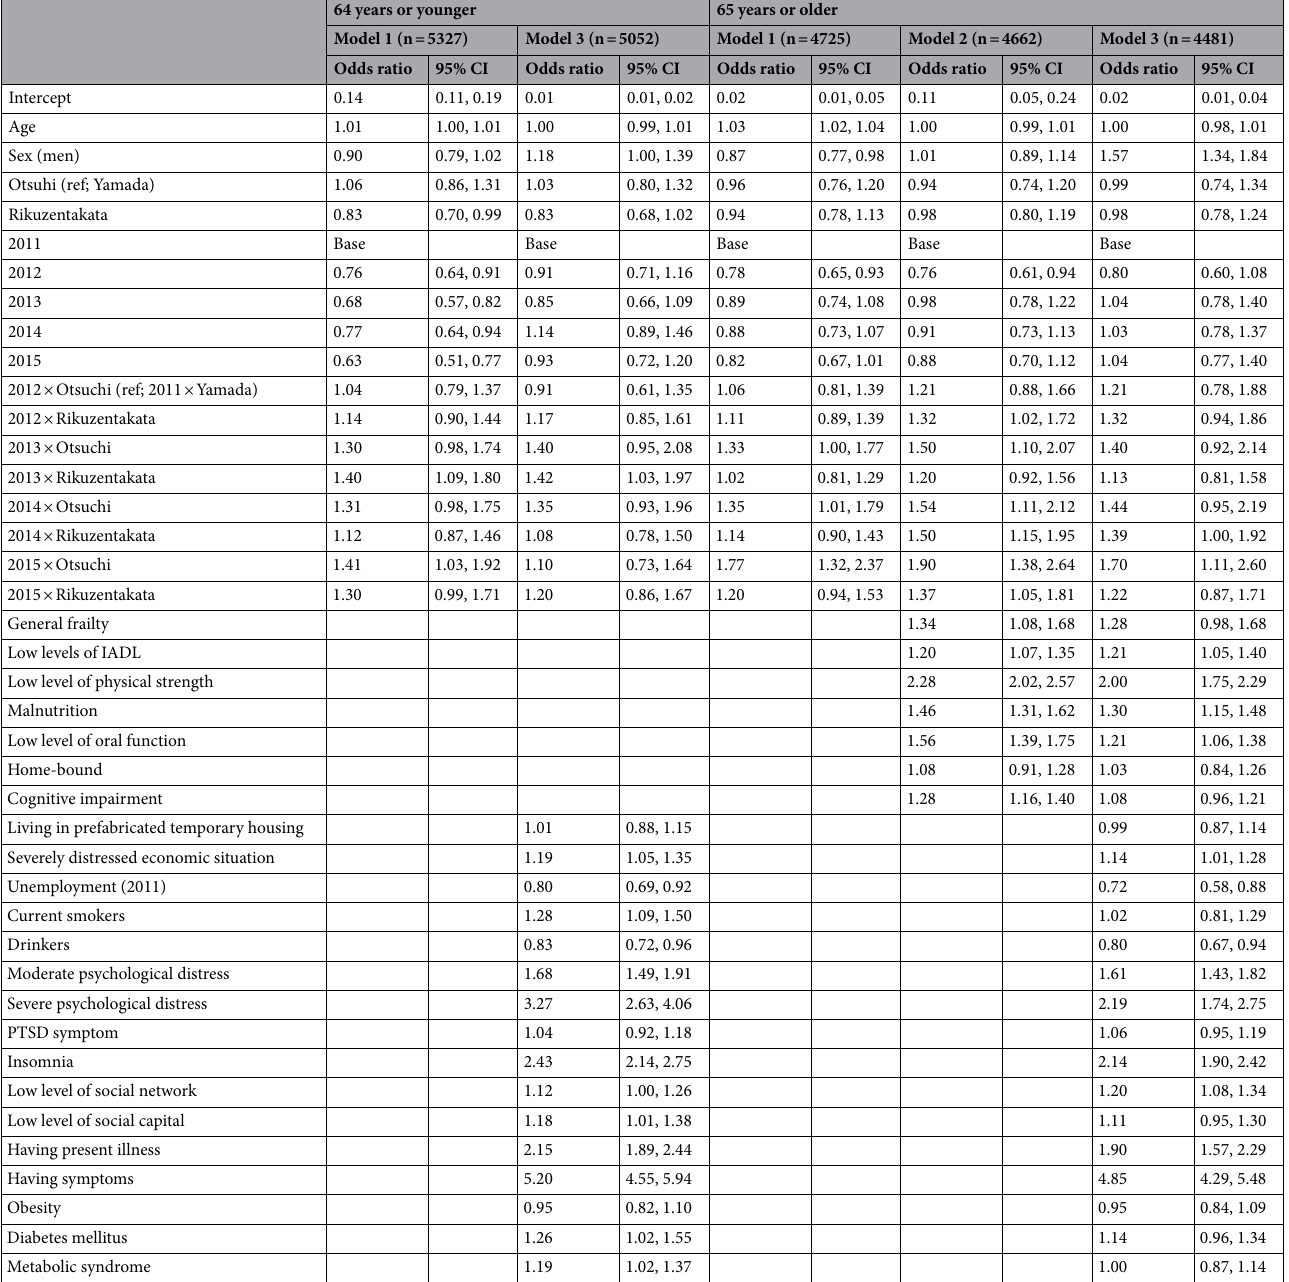
Table 2. Comparison of poor self-rated health among municipalities using the generalized mixed effect models. CI confidence interval, IADL instrumental activities of daily living, PTSD post-traumatic stress disorder. The number of participants represents the individuals who participated in at least one survey from 2011 to 2015 and had all variables adjusted in each model in one’s participated survey. Because people aged 64 years or younger did not have data about functional disability, there was not model 2 in the people aged 64 years or